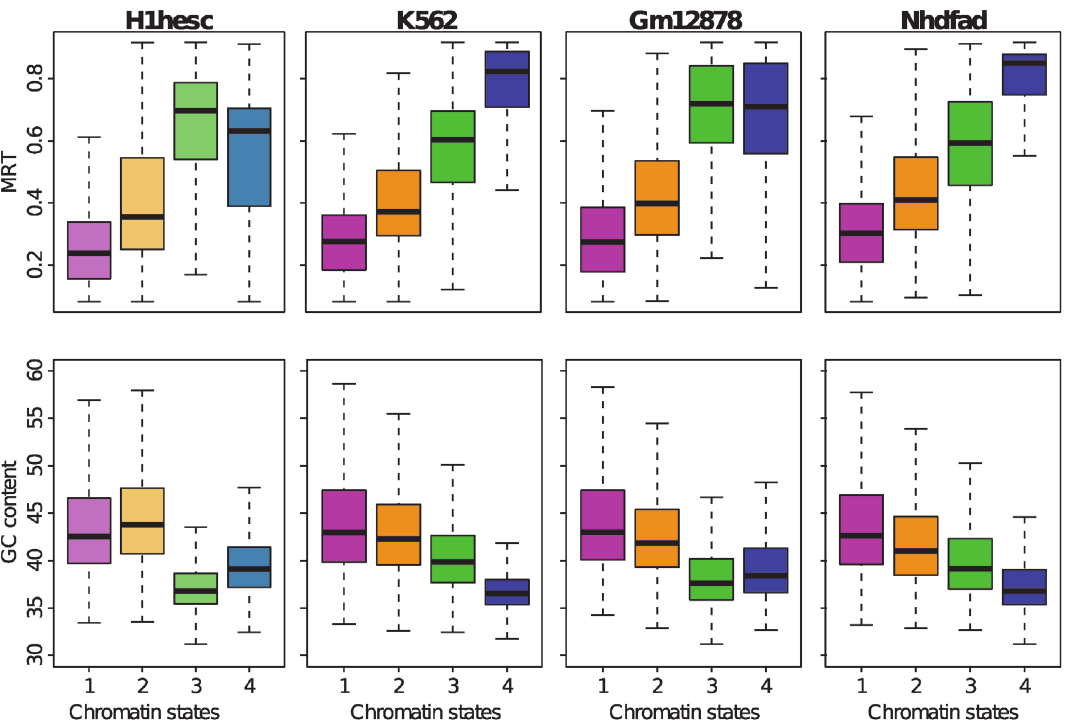
Figure 4. MRT and GC distributions in the four chromatin states for H1hesc and three differentiated cell lines (K562, Gm12878, Nhdfad). (First row) Boxplot of MRT computed in 100 kb non-overlapping windows per chromatin state. (Second row) Boxplots of GC content computed in 100 kb non- overlapping windows per chromatin state. Same color coding as in Fig.